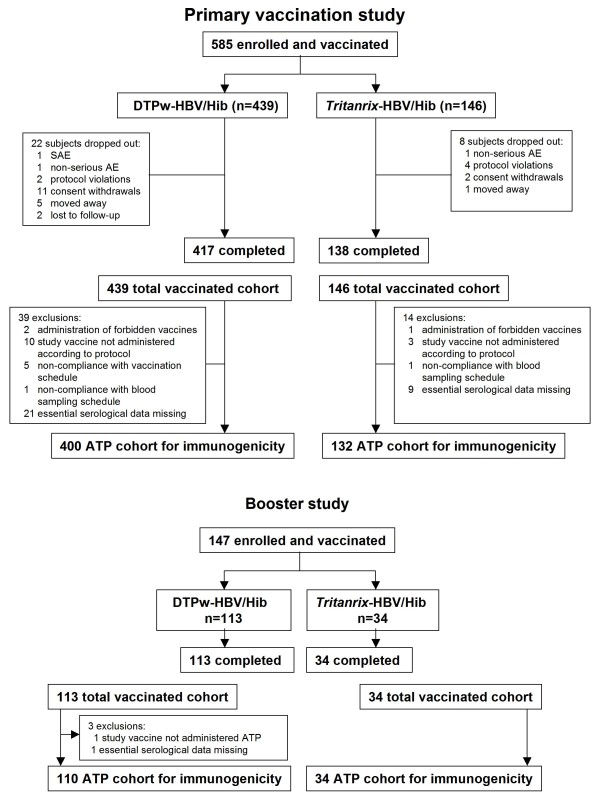
Subject disposition